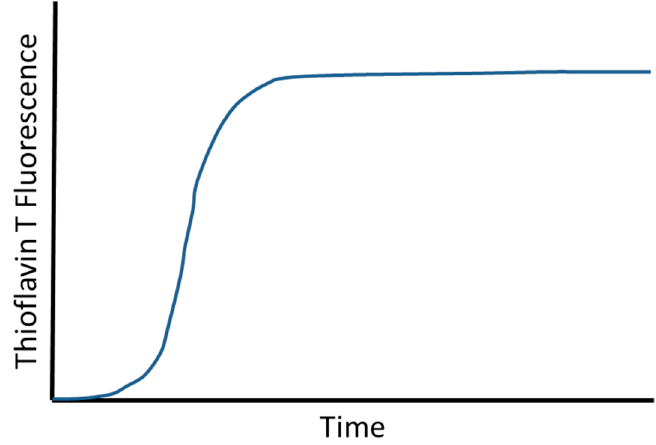
Figure 1. Scheme of a typical amyloid-beta protein (A β ) aggregation assay result. Even at high micromolar A β concentrations, there is always a lag phase in ThT fluorescence detected A β aggregation experiments, followed by a steep increase in ThT-positive assembly formation and a saturation plateau at the end, when the monomer building blocks become depleted and limiting.